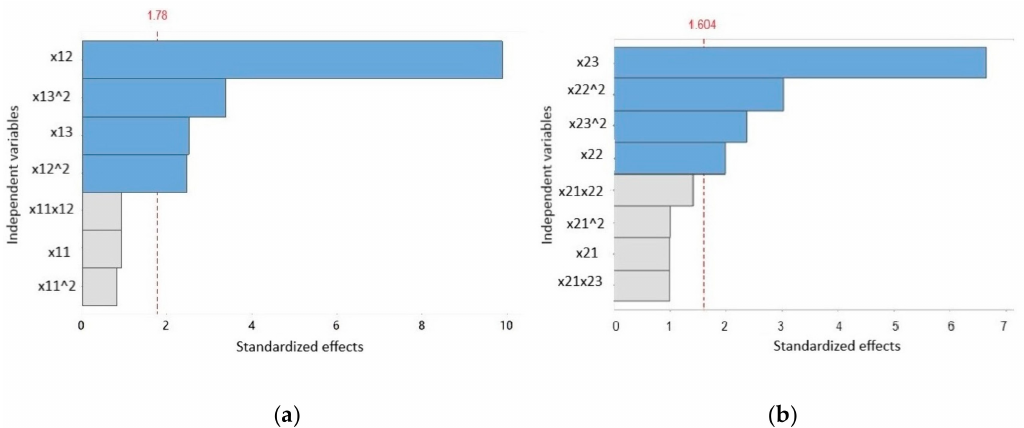
Figure 5. ( a ) Pareto chart of standardized e ff ect of regression-model factors for zinc extraction. Note: x 11 , solid ratio; x 12 , temperature; x 13 , sulfuric acid concentration. ( b ) Pareto chart of standardized e ff ect of regression-model factors for tungsten extraction. Legend: x 12 , temperature; x 22 , pressure; x 23 , residence